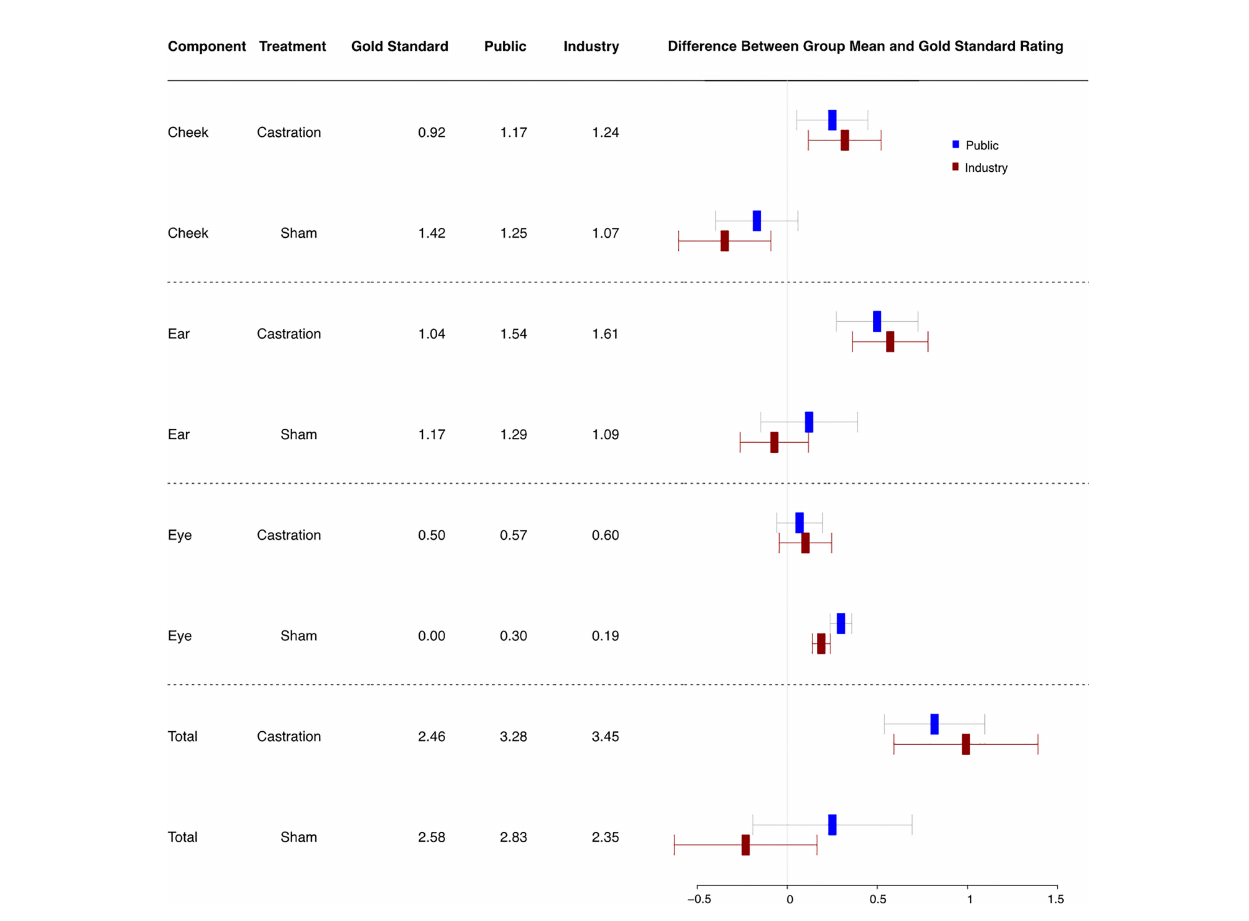
FIGURE 1 | Respondents ’ scores [general public (n = 66) and industry respondents (n = 53)] by feature (eye, ear, cheek) and treatment (castration or sham- handled) relative to gold standard scores (n = 4).